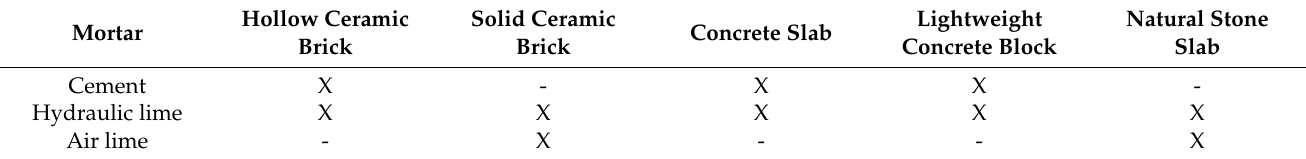
Table 1. Types of mortar and corresponding application substrates.